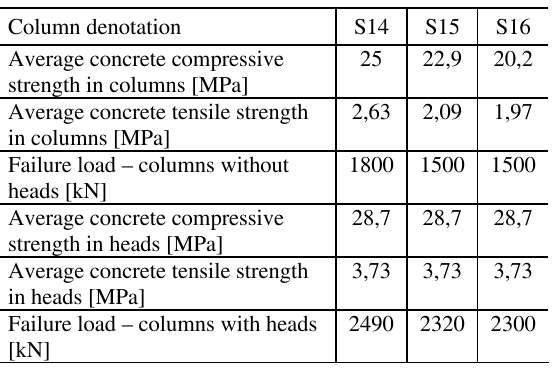
Table 2 . Comparison of test results for columns loaded